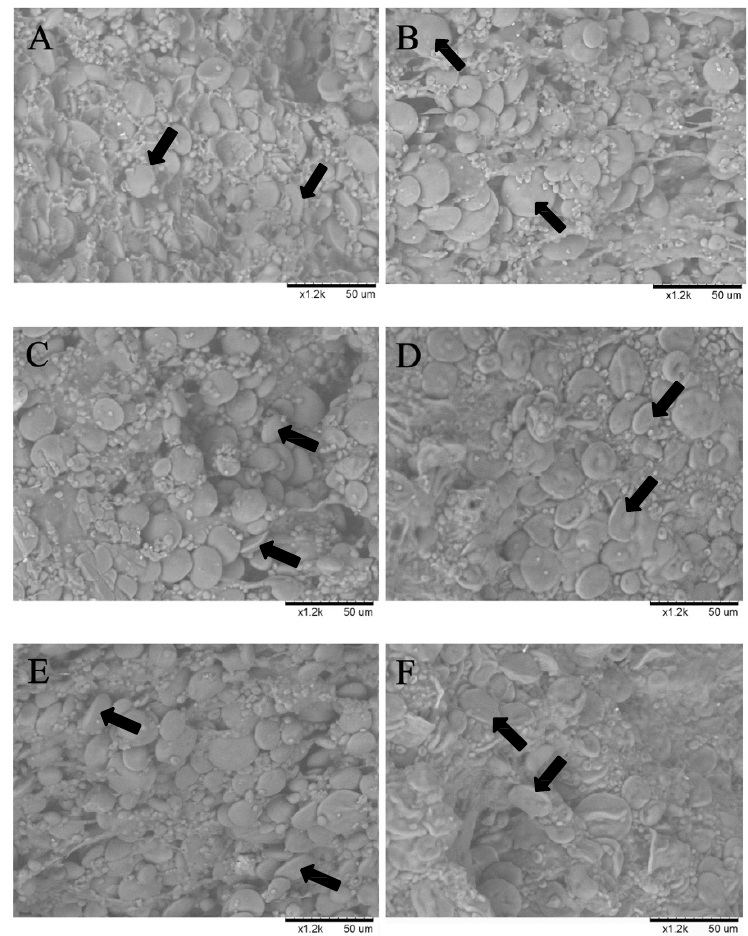
Figure 1. SEM micrographs of uncooked (left) and cooked (right) GP0 ( A , B ), GP5 ( C , D ), and GP10 ( E , F ) pasta samples. The black arrows indicate starch granules.